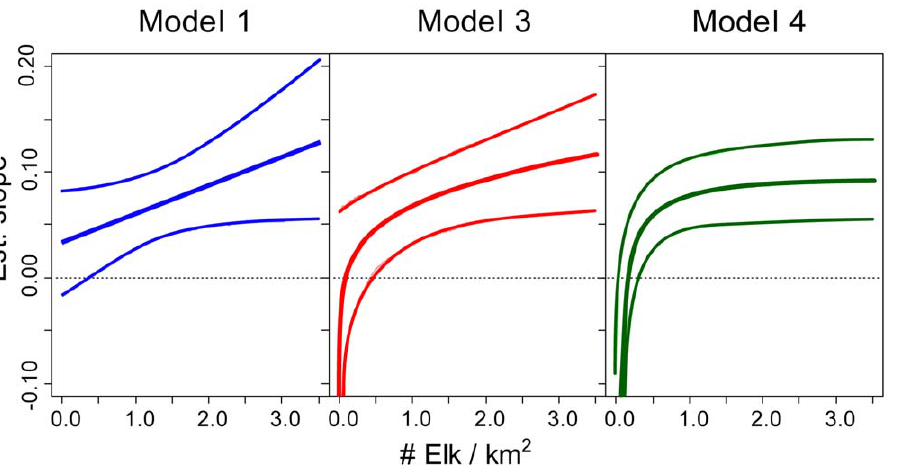
Figure 3. The overall relationship between elk density and the annual rate that brucellosis is increasing on the logit scale for three of the top models. The relationship is constrained to be linear (Model 1), a power function (Model 3) or a saturating type II response (Model 4). Thin lines are the 95% credibility intervals.